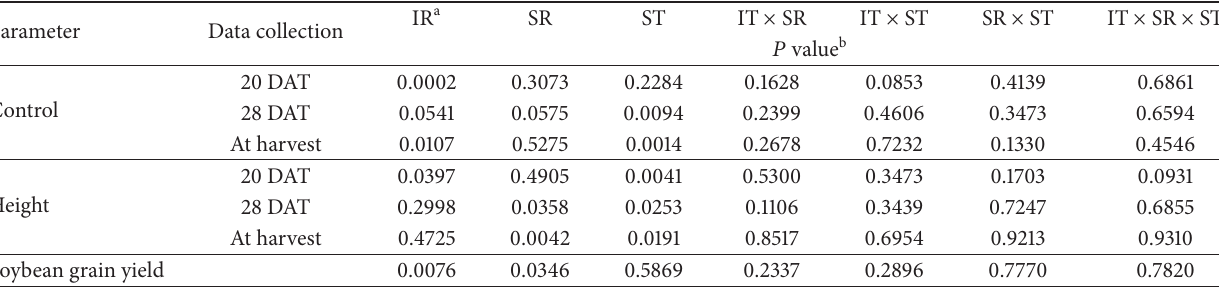
Table 1: Significance of the main effects of initial glufosinate application rate (POST1), sequential glufosinate application rate, and sequential glufosinate application timing (POST2 or POST3) and interactions among main effects pooled across environments 20 and 28 d after treatment (DAT) and at harvest for glyphosate-resistant rhizomatous johnsongrass control and height as a percent of the nontreated and soybean grain yield.